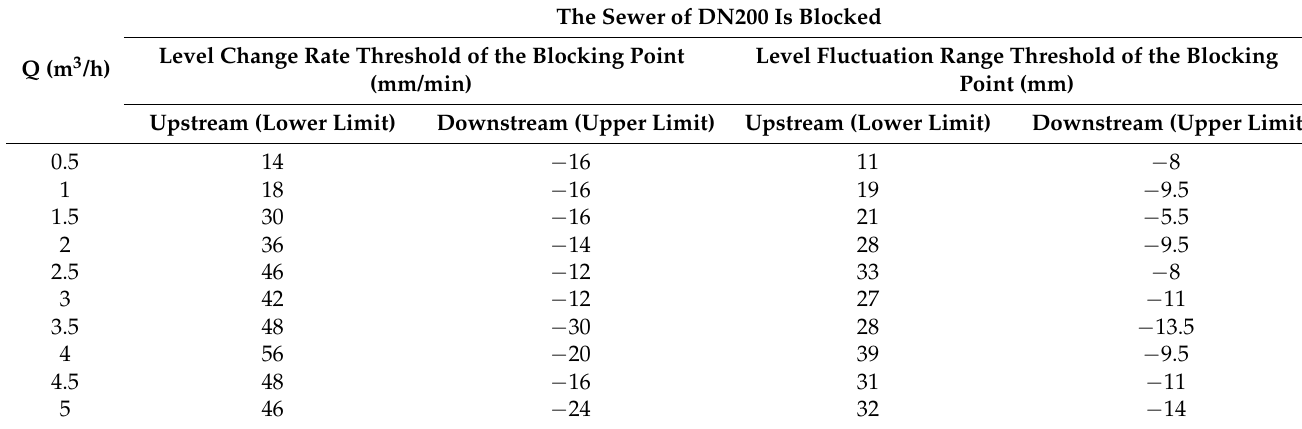
Table 5. Sewer blockage identification matrix of DN200.